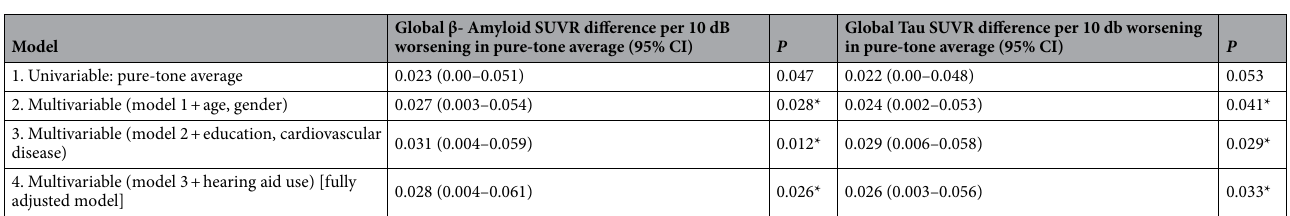
Table 2. Regression models for global β-amyloid and Tau SUVR based on pure-tone average hearing. SUVR standardized uptake value ratio, CI confidence interval. *Significant, P <